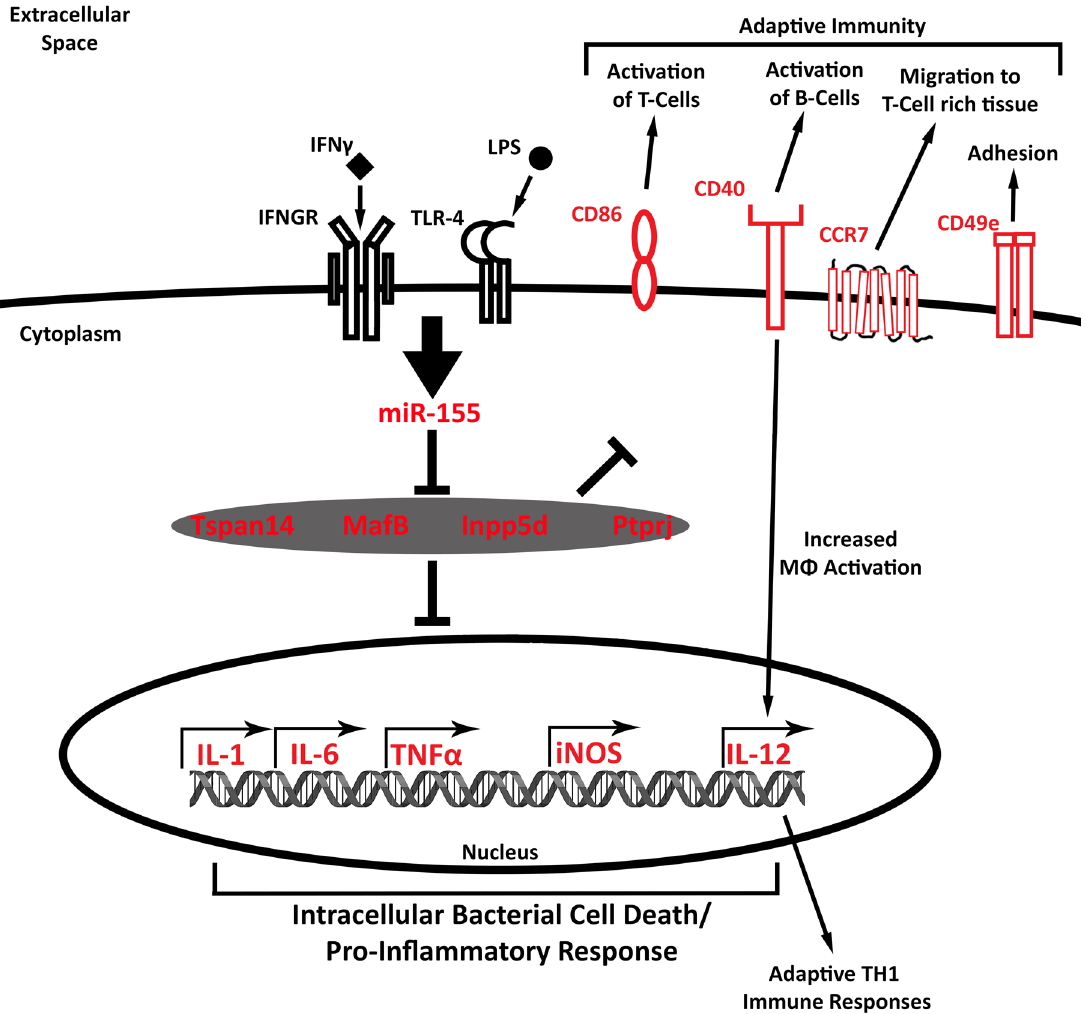
Fig 6. miR-155 dependent M1 signature transcriptional networks. (A). Model of molecules involved in miR-155 dependent M1 activated transcriptional networks, identified by Ingenuity Pathway Analysis. miR-155-dependent M1 genes up-regulated more than 2 Fold Change (FC) in wild-type (WT) M1vs. WT M0 macrophages that were up-regulated to a lesser extent in knockout (KO) M1 vs. KO M0 macrophages are highlighted in